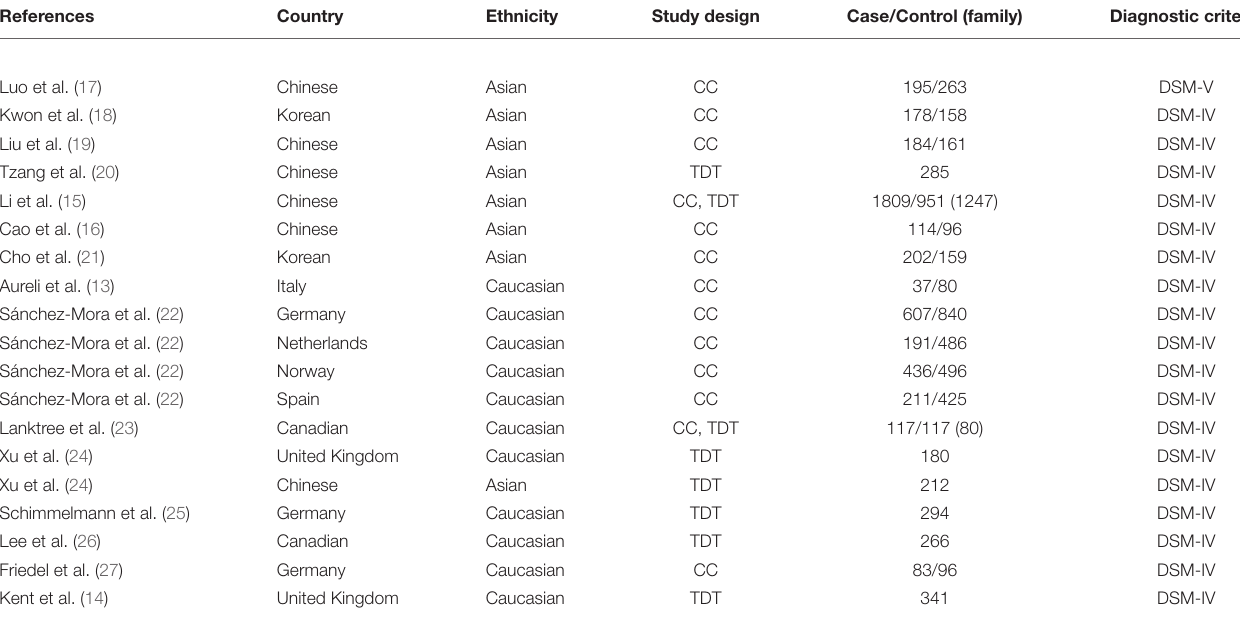
TABLE 1 | Main characteristics of studies included in the